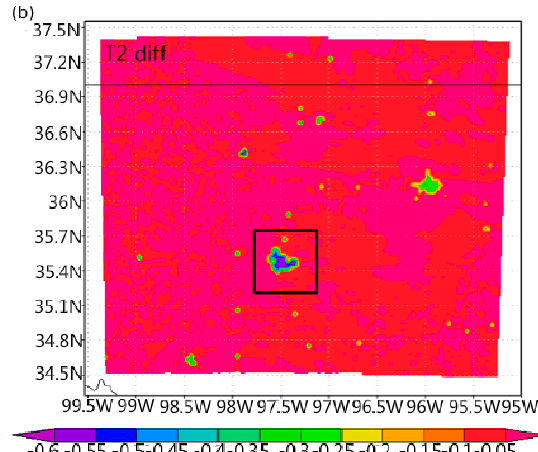
Figure 11. ( a ) WRF simulated surface temperature difference at 18:00 UTC, 19 July 2003, in OKC for the T skin difference (sensitive run–control run); ( b ) WRF simulated surface temperature difference at 18:00 UTC, 19 July 2003, in OKC for a 2 m T air difference (sensitive run–control run). Temperature unit is in K; OKC is highlighted by the rectangle.